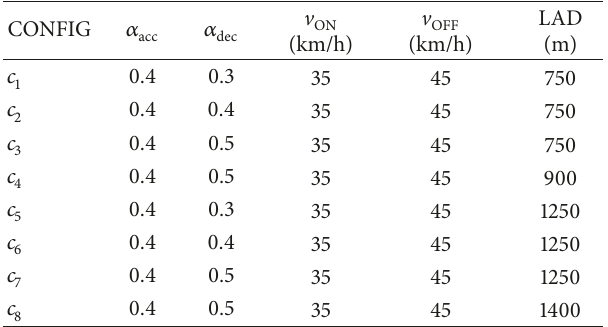
Table1:ExperimentalFCDAIDconfigurationsdeployedonthetest